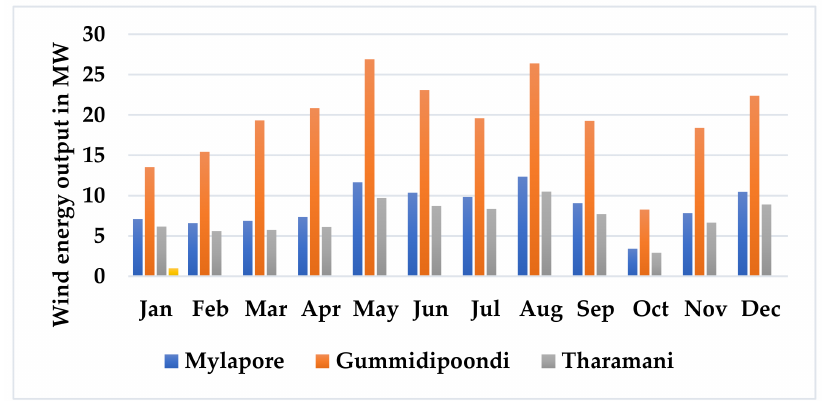
Figure 16. Monthly wind energy output at selected